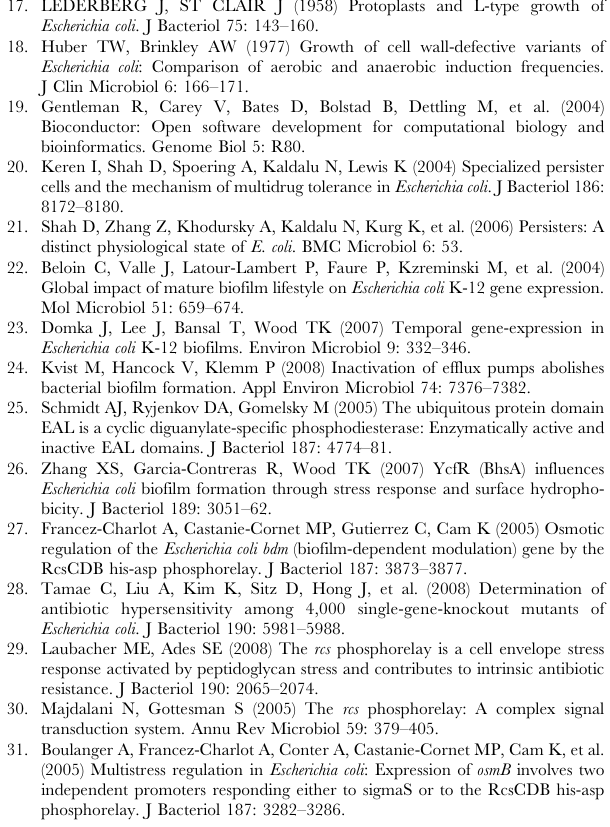
Table S1 Genes overexpressed 4-fold and higher in E. coli L- form colonies versus classical colonies